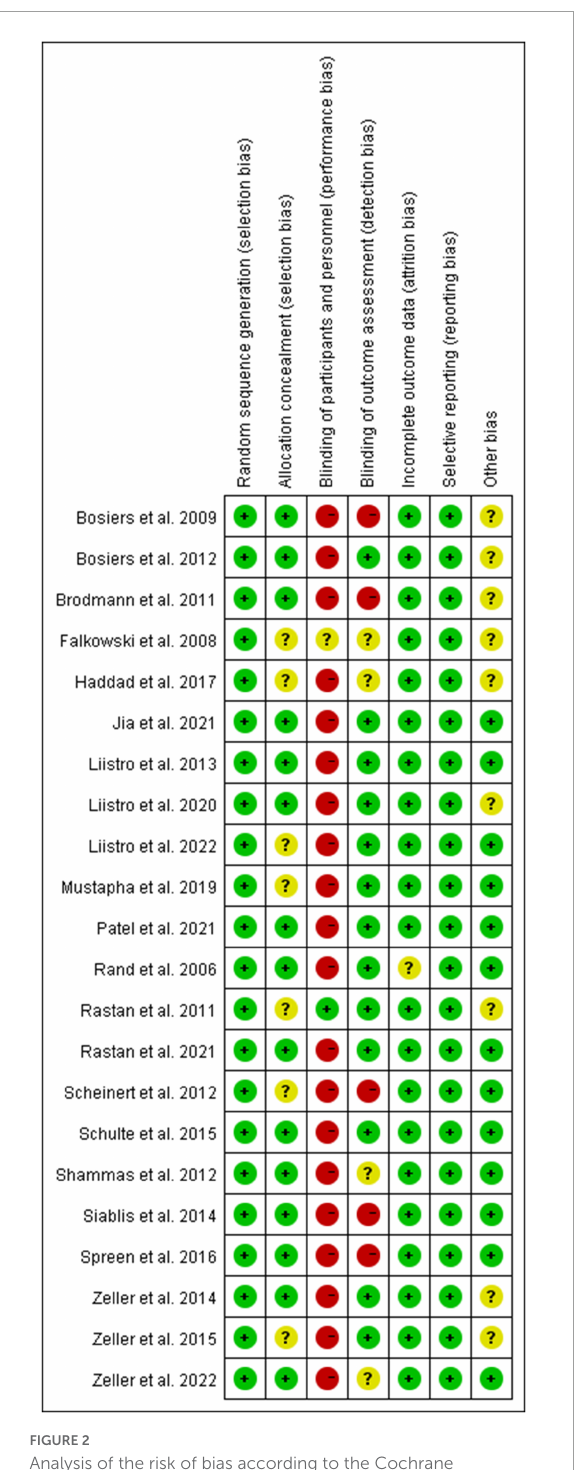
FIGURE2 Analysis of the risk of bias according to the Cochrane Collaboration’s tool.